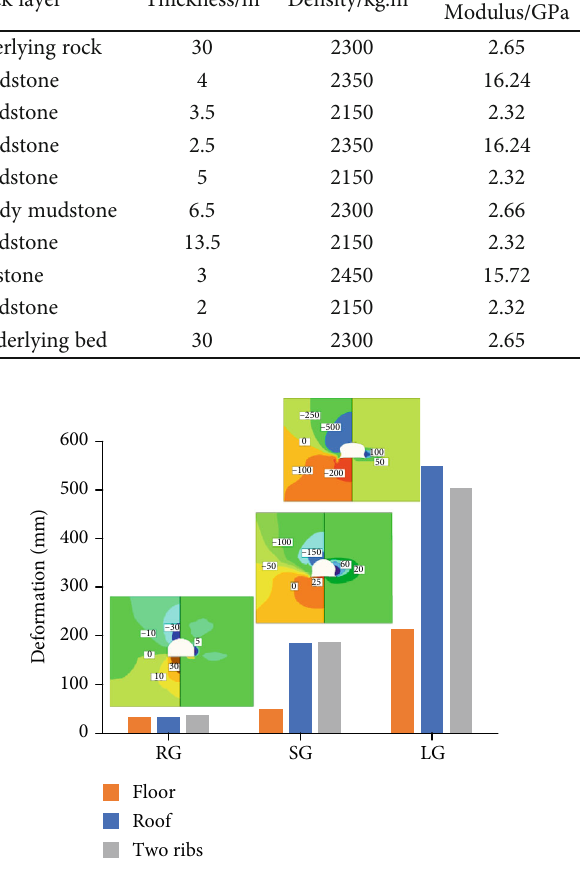
Figure 3: The roadway displacement distribution and statistics (RG represents for routine group, SG represents for short-term water seepage group, and LG represents for long-term water seepage